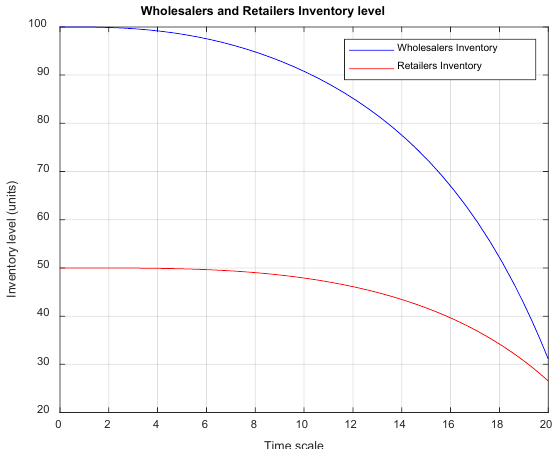
Figure 5. Wholesaler and retailer inventory levels.